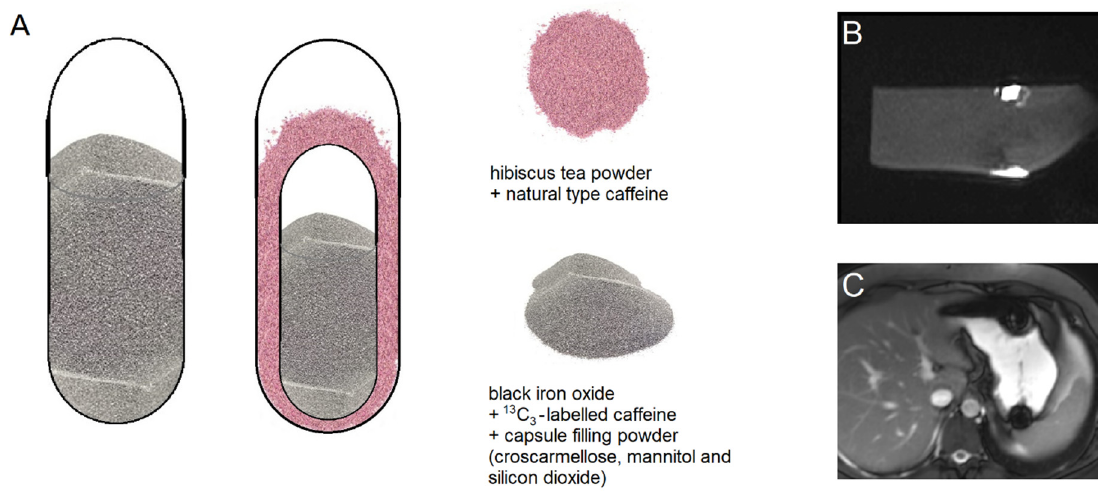
Figure 1. ( A ): Composition of the single capsules of size 00 (left) and composition of the size 3 capsule in size 00 capsule formulations (mid), ( B ): T1 weighted VIBE of in vitro disintegration of hard capsule with hibiscus tea powder in water, ( C ): T2*/T1 weighted TRUFI of in vivo disintegration of hard capsule surrounded by water in stomach. Table 1. Study arms and respective evaluation times.